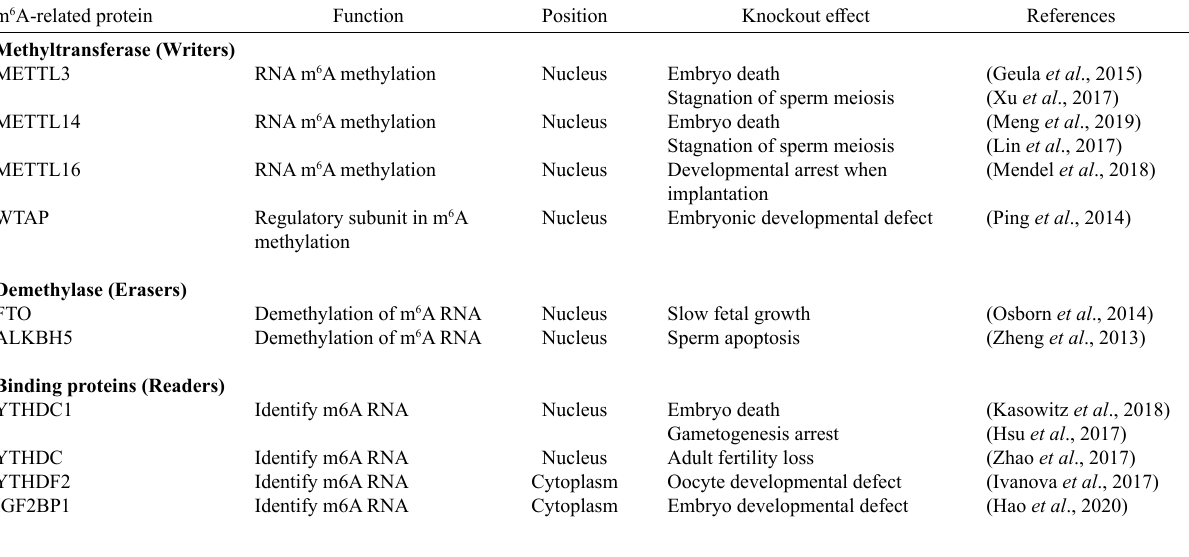
Table 1 – m 6 A methylation related to embryo